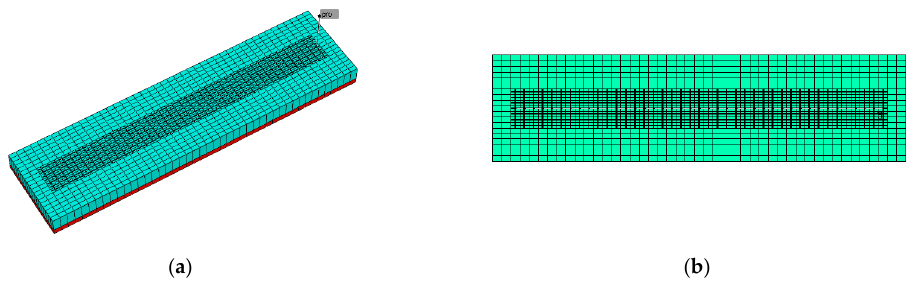
Figure 1. Grid distribution of numerical model. ( a ) 3D view of numerical model. ( b ) Top view of numerical model.